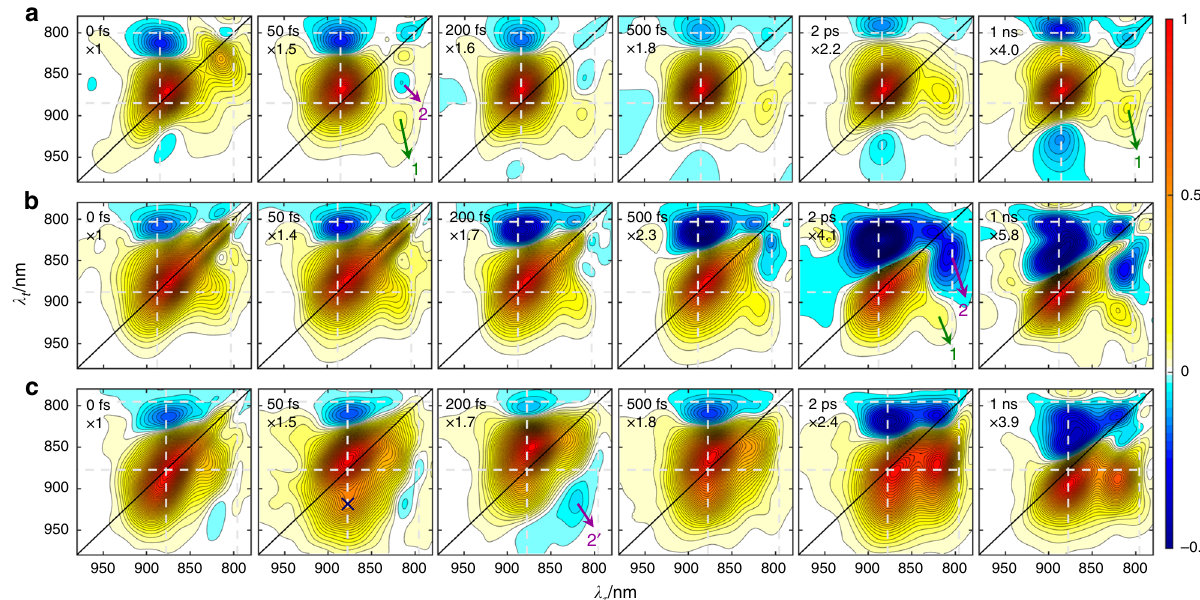
Fig. 2 77 K absorptive total two-dimensional (2D) spectra. 2D spectra of M1 ( a ), M2 ( b ), and M3 ( c ). Symbols λ τ and λ t denote the excitation and detection wavelengths, respectively; the indicated population time T is shown in the left-top corner of each panel. The spectra are normalized to the maximum of the diagonal P signal; the relative amplitude multiplier is shown below the